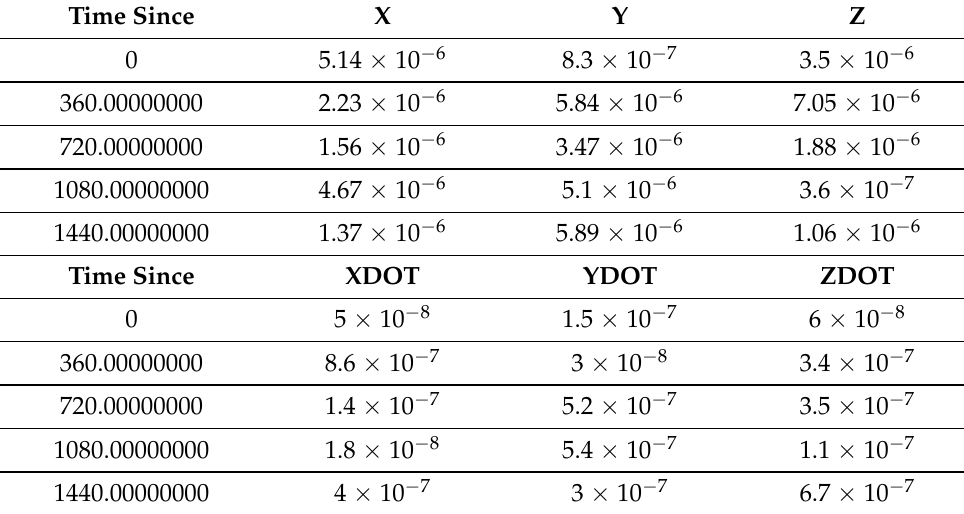
Table 1. The accuracy comparison between the two cases. Difference in the values of the sample case provided in Spacetrack Report No. 3 and the results of the Matlab model. The output is given at 360-min intervals in km and